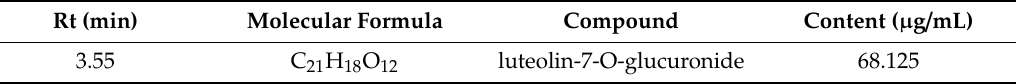
Table 3. Quantification of luteolin-7-O-glucuronide in 8g / L E. acoroides aqueous extract.